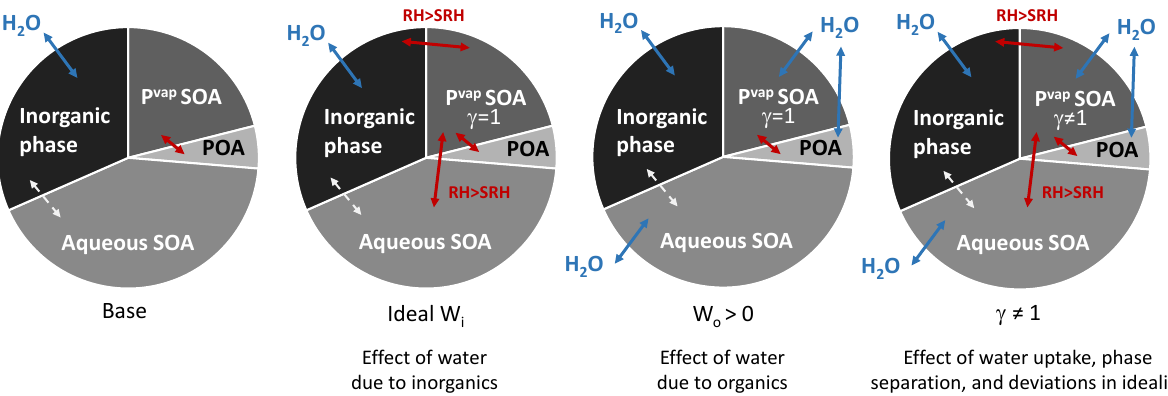
Figure 2. Interactions of the inorganic phase (e.g., sulfate, nitrate, ammonium, aerosol water), aqueous SOA, vapor-pressure-driven SOA, and POA in the base and sensitivity simulations. Blue arrows depict water partitioning/uptake. Red arrows indicate semivolatile partitioning interactions via modified Raoult’s law. The white dashed arrows indicate aqueous SOA interaction with the inorganic phase (via liquid water, acidity, and particle